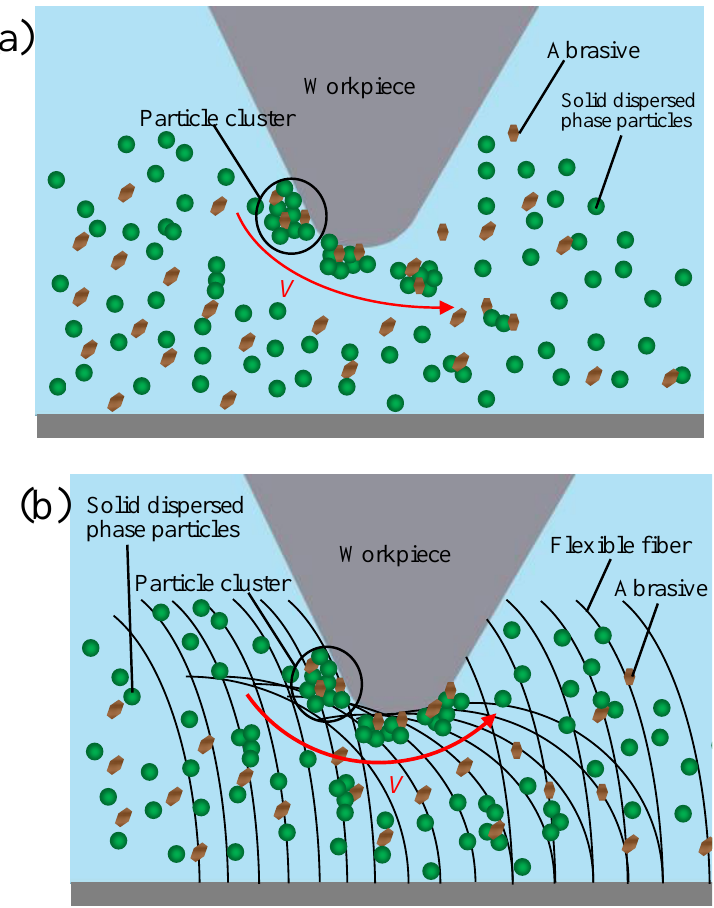
Figure 1. Schematic illustration of FF-FRP process for cemented carbide insert preparation: ( a ) STP, ( b ) FF-STP.